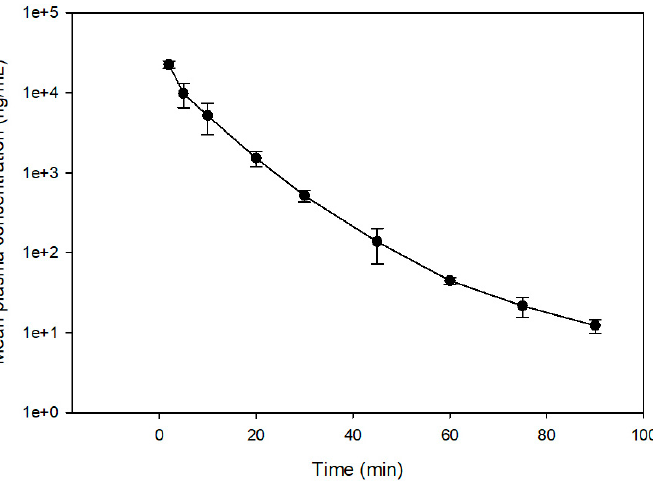
Figure 5. The profiles of the mean ± SD plasma concentration versus time after 25 mg/kg BW OXP intravenous injection to rats ( n = 3).